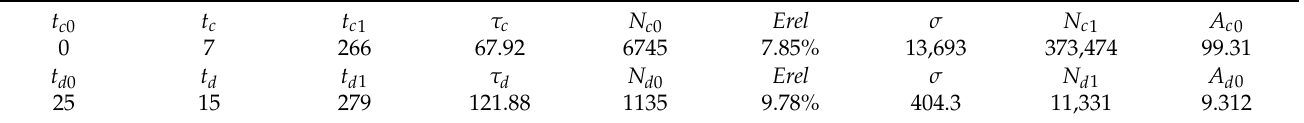
Table 2. Different spread phases and identification of the accelerated